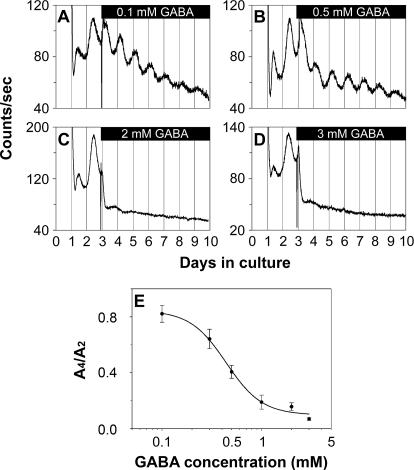
GABA Sets the Amplitude of Retinal PER2::LUC Rhythms in a Dose-Dependent Manner(A–D) Representative PER2::LUC bioluminescence traces recorded from cultured mPer2Luc retinal explants that received different doses of GABA treatment. Bars indicate the duration of GABA treatment.(E) Dose-dependent inhibitory action of GABA on the amplitude of retinal PER2::LUC rhythms. The ratio of the peak-to-trough amplitude of the fourth cycle to that of the second cycle (A4/A2) was plotted as a function of the external GABA concentration. Data are represented as mean ± SEM (n = at least 3 explants per point).